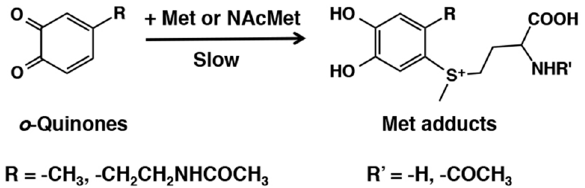
Figure 8. Reaction of o -quinones with methionine and N -acetylmethionine [46]. Note that the position of attachment of thio-ether group has not been confirmed.